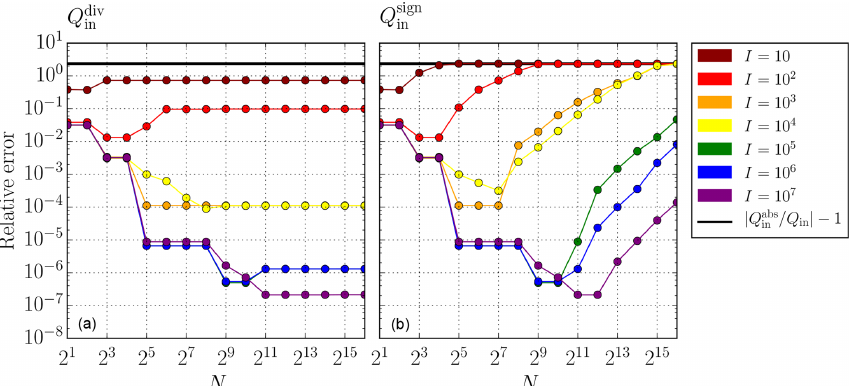
Figure 3. Oscillating exchange flow (see Sect. 2): relative error of Q in computed with (a) the dividing salinity method and (b) the sign method depending on the number of time steps I (colour) and salinity classes N . The sign method (5) and the dividing salinity method (7) coincide for a small number of salinity classes, but the error of the sign method converges in the limit of large N towards the error of the absolute bulk values (black line, 6). In contrast, the error of the dividing salinity method converges towards a constant value. The errors of both methods decrease with increasing number of time steps I